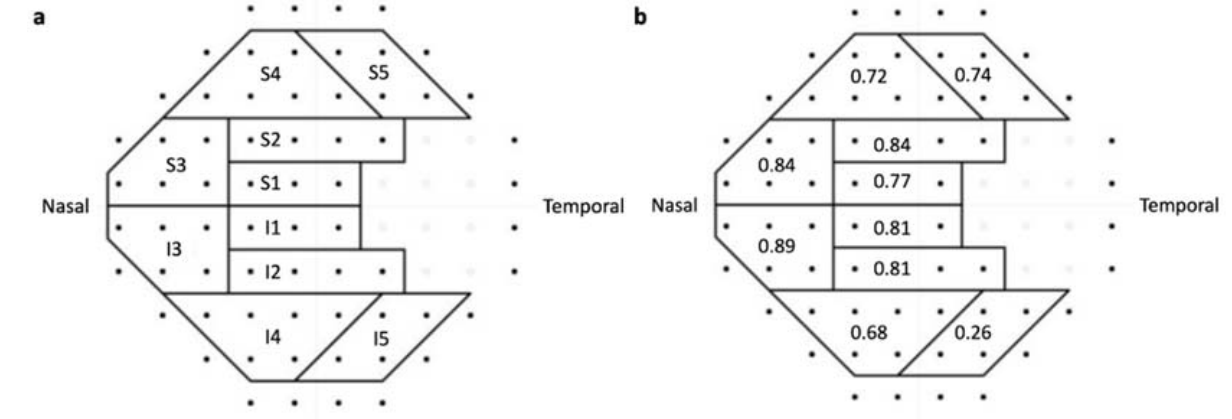
Figure 3. ( a ) The glaucoma hemifield test (GHT) sectors and its corresponding locations on central 30 ◦ visual field grids. ( b ) Correlations of GHT sectors between LUXIE and Humphrey Field Analyzer 3.